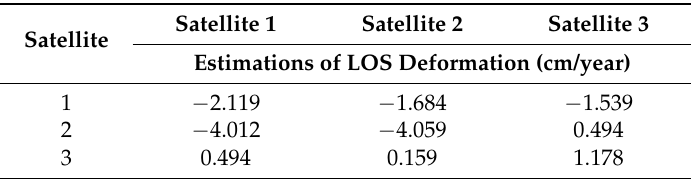
Figure 6. Estimation of elevation and deformation parameters along line of sight (LOS). ( a ), ( b ) and ( c ) correspond to the estimated results of Satellite 1, Satellite 2, and Satellite 3, respectively. Table 7. The results of the LOS deformation estimations.